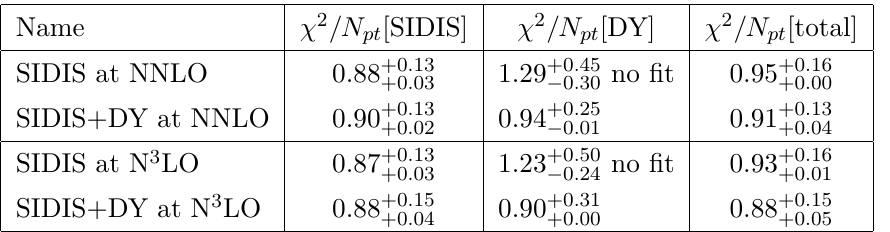
Table 2. Values for χ 2 /N pt in different fits. Note, that for the cases included in the fit the CF value of χ 2 lies outside the 68%CI. This is because CF realizes the minimum of χ 2 distribution, whereas the 68%CI (roughly) excludes 16% of boundary